Question: Identify the chart type used in this figure.
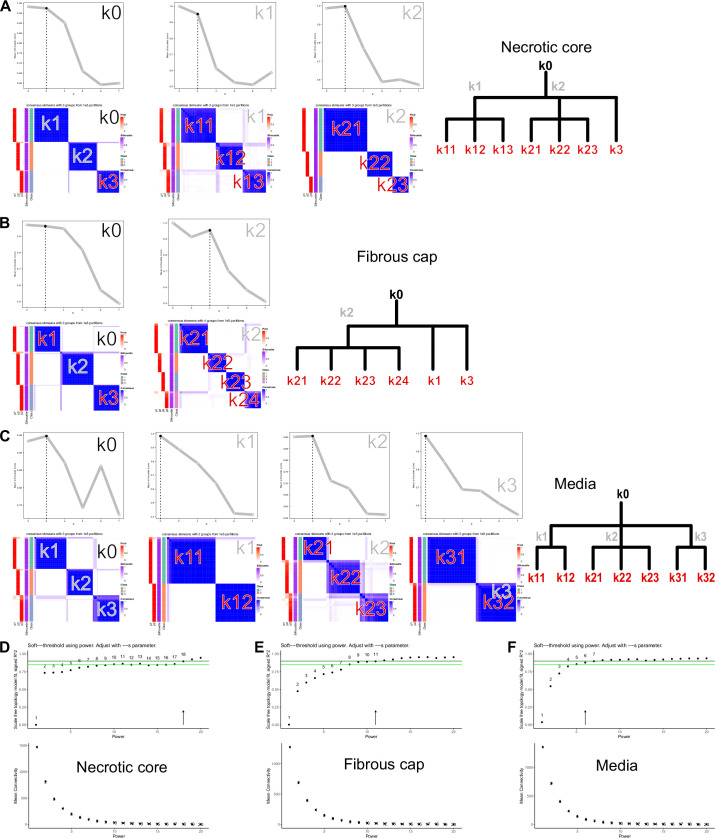
Answer: heatmap